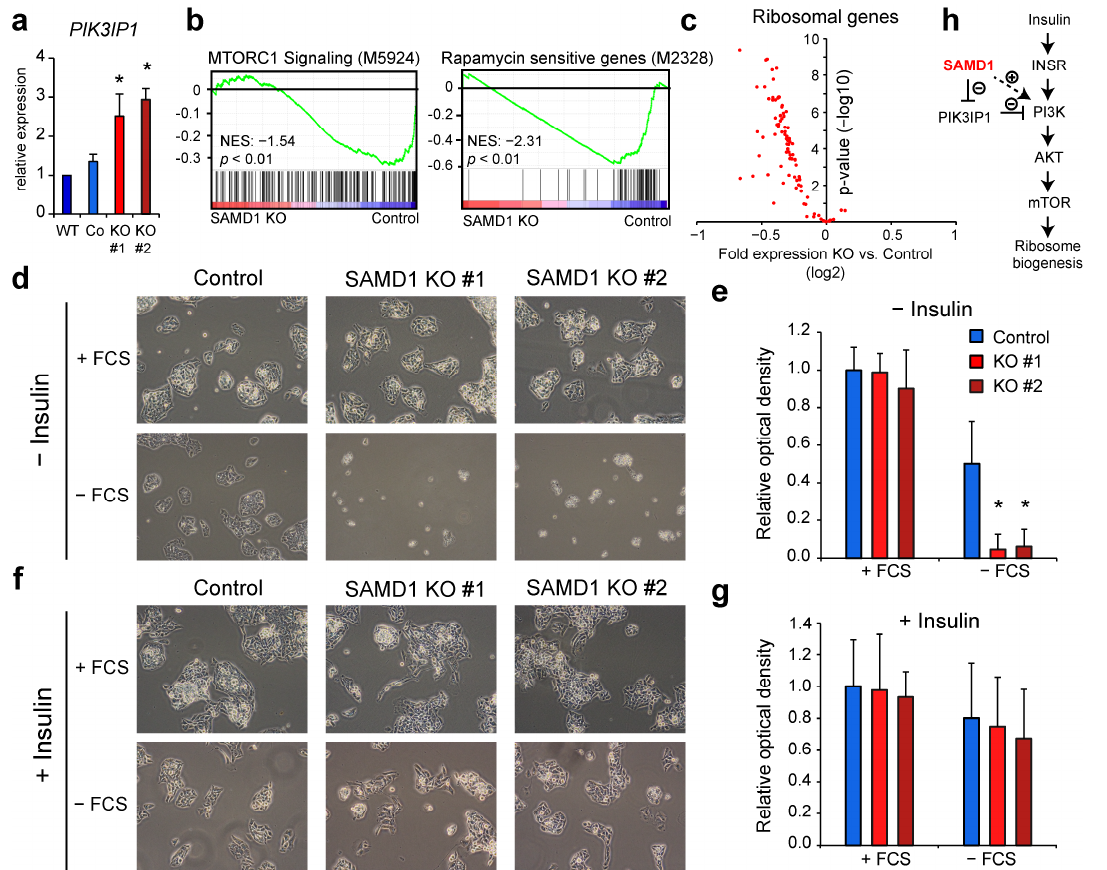
Figure 4. SAMD1 deletion impairs the mTOR signaling pathway and sensitizes cells to serum starvation. ( a ) Expression of PIK3IP1 in wild-type, control, and SAMD1 KO cells, measured via RT-qPCR. Error bars indicate the SD of three biological replicates. * p < 0.05 (Student’s t -test) ( b ) GSEA of mTOR signaling and rapamycin-sensitive genes in SAMD1 KO cells. ( c ) Volcano plot of ribosomal genes comparing expression in control and SAMD1 KO cells. ( d ) Representative bright- field microscopy of SAMD1 KO and control HepG2 cells upon serum starvation. ( e ) MTT viability assay of cells treated as in ( d ). Error bars indicate the SD of three biological replicates. * p < 0.05 (Student’s t -test). ( f ) Representative bright-field microscopy of SAMD1 KO and control HepG2 cells upon serum starvation supplemented with insulin. ( g ) MTT viability assay of cells treated as in ( f ). Error bars indicate the SD of three biological replicates. * p < 0.05 (Student’s t -test). ( h ) Model of SAMD1’s influence on the mTOR signaling pathway. In ( a , d – g ) the “#” refers to two distinct SAMD1 KO